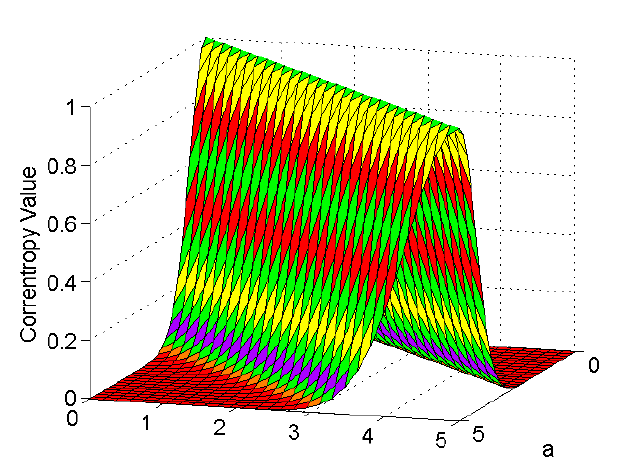
Figure 3. Correntropy when λ =